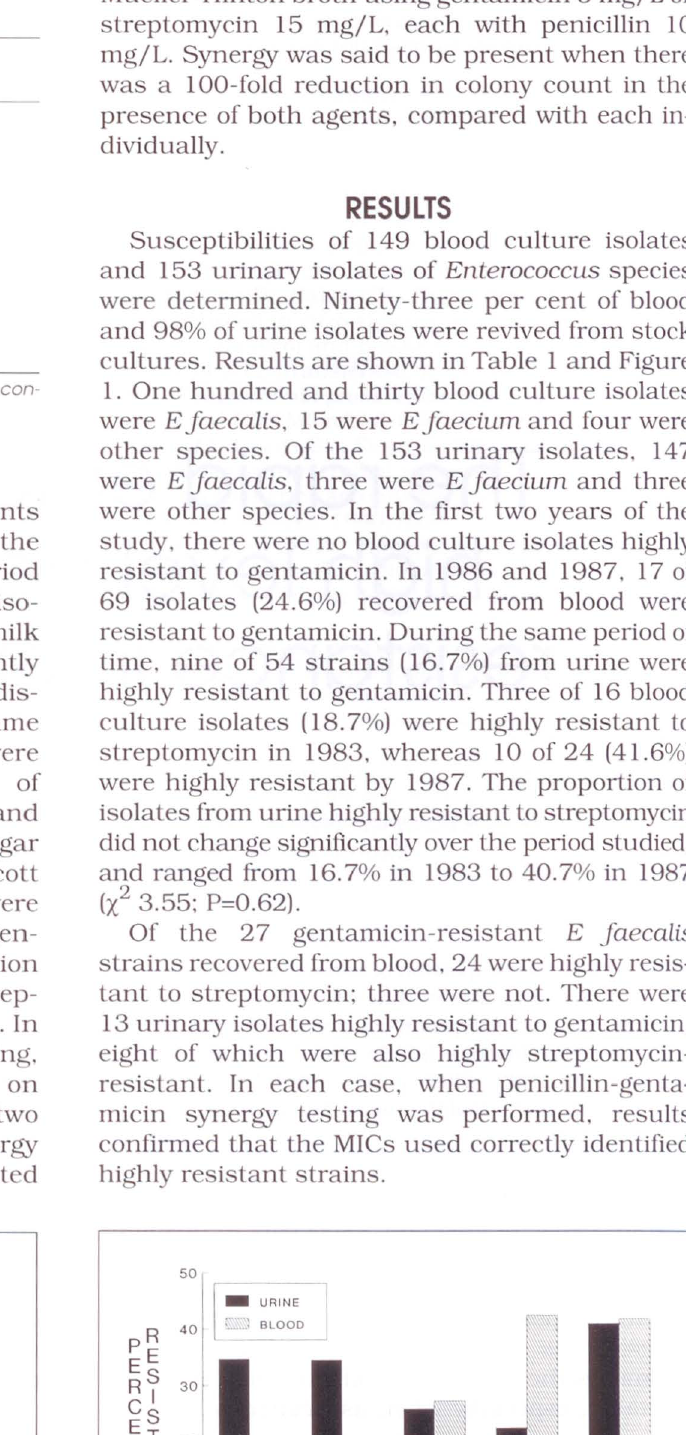
Summary of enterococcal strains tested